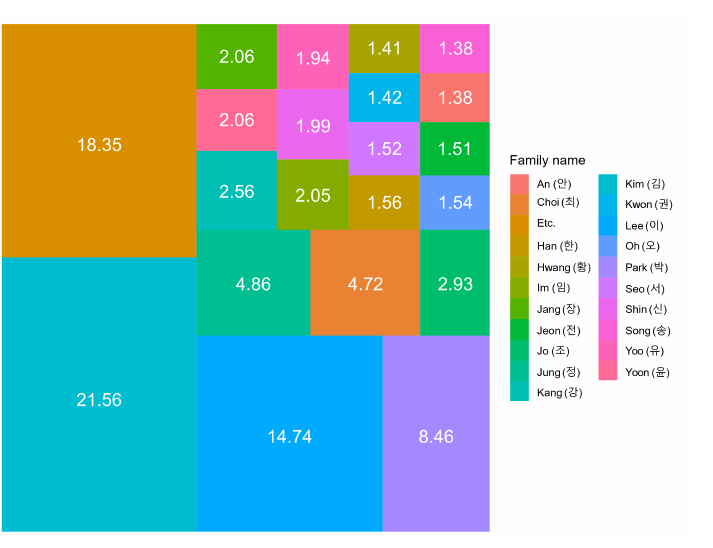
Figure 2. TreeMap of leading family names and their